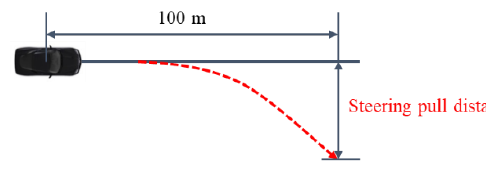
Figure 9. Steering pull evaluation by free control test. Table 1. The estimation conditions of steering pull.